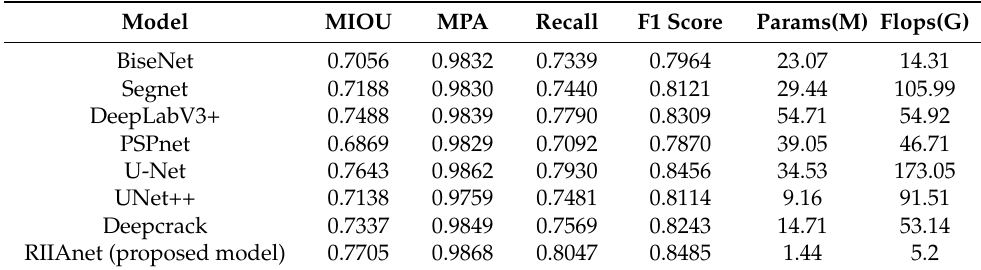
Table 3. Performance and computation metrics for different